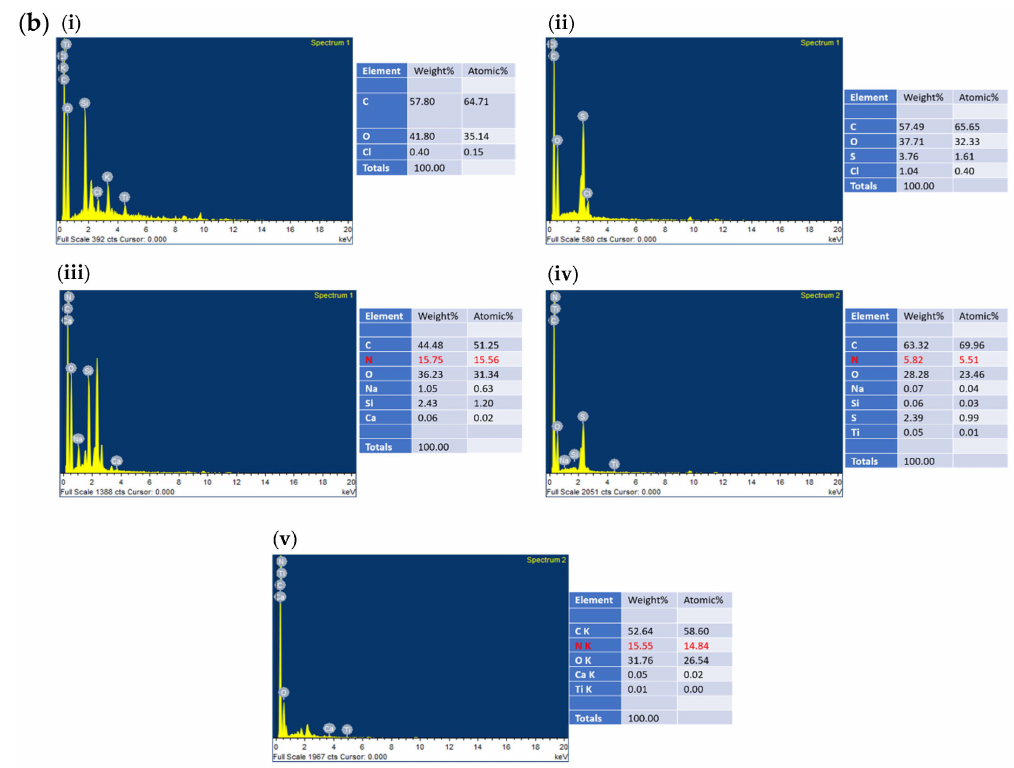
Figure 3. Characterization of Cellulose Derivatives SEM and EDX (Analysis) in solid state of derivatives confirming the synthesis of the derivatives. ( a ) SEM images were taken at 20 µ m, 5 µ m, 2 µ m and 500 µ m. ( b ) EXD Analysis ( i ) MCC, ( ii ) C TOS , ( iii ) Cell Hyd, ( iv ) Cell DEA, ( v ) Cell DETA.